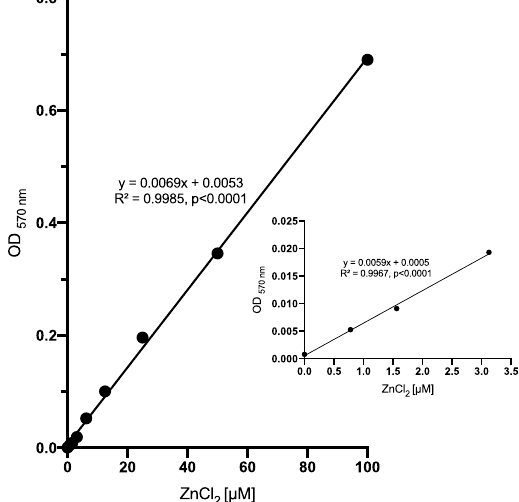
Figure 4. Zinc levels can be measured using iDTZ. There was a highly significant correlation between zinc concentration and the absorbance readings at 570 nm (R 2 = 0.9985, p <